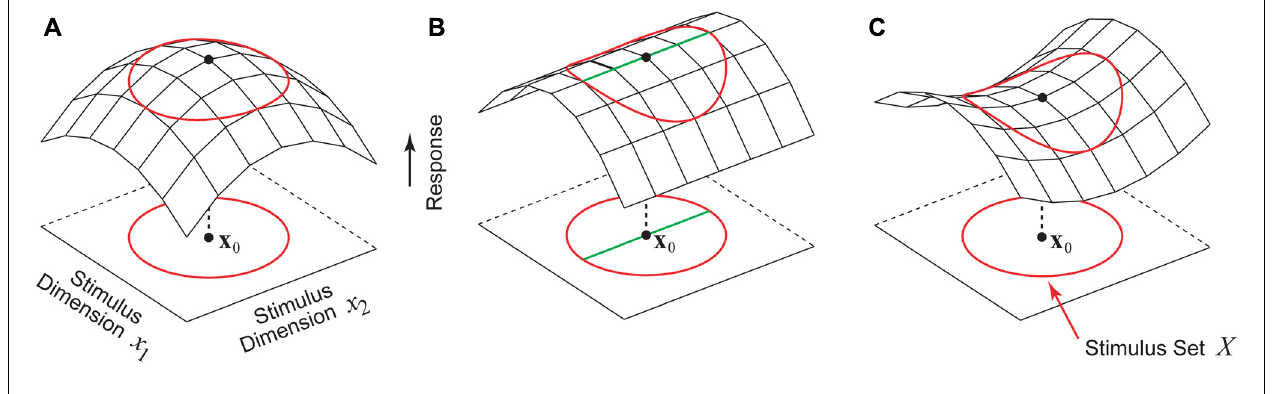
dimension but is insensitive to the second dimension. Instead of a single optimal stimulus x 0 there is a continuum of optimal stimuli (green line). (C) A neuron whose stimulus–response function around the point x 0 is saddle-shaped. Along one stimulus dimension x 0 is a firing rate maximum, and along the other stimulus dimension x 0 is a